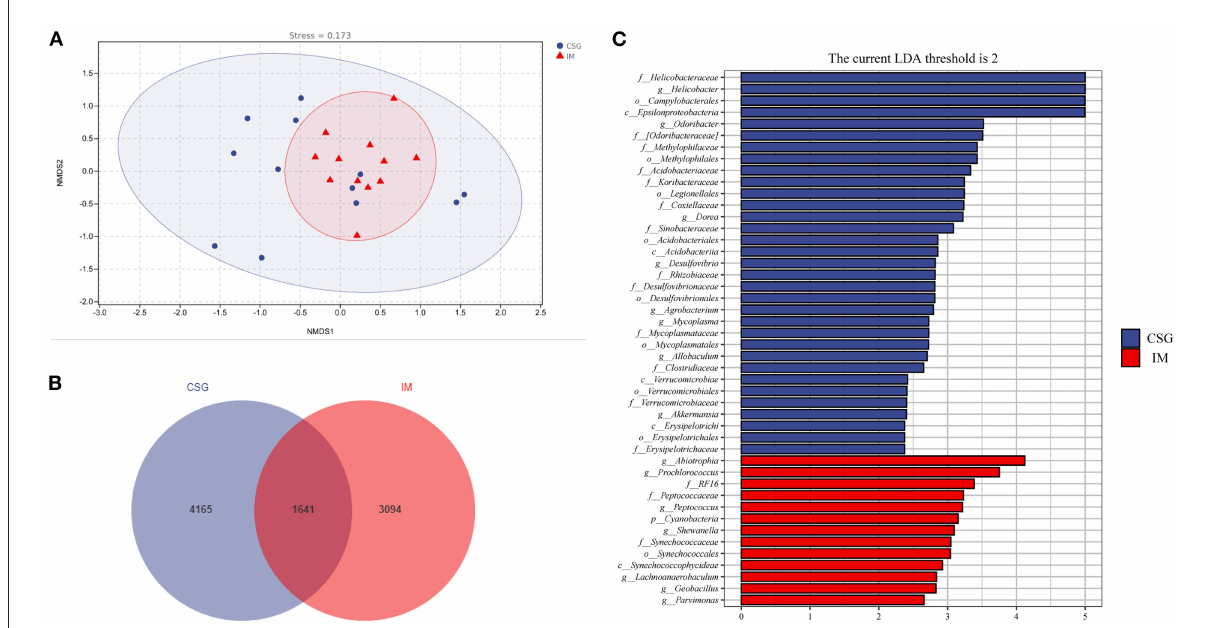
FIGURE4 Species differences and marker species analysis of gastric juices microbiota in patients with CSG and IM. (A) NMDS analysis. (B) ASV/OTU Venn diagram. (C) LEfSe analysis.